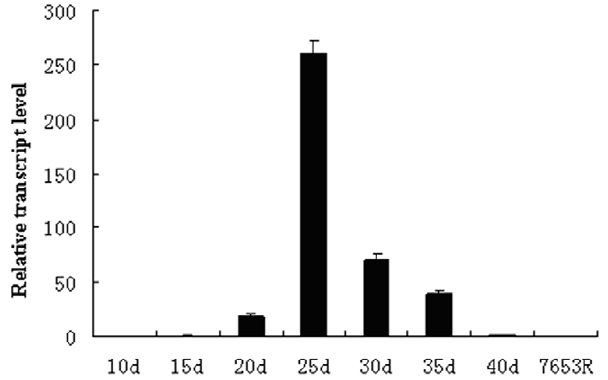
Figure 4. Expression patterns of dmtH gene in free-living cells and symbiotic nodules. Gene expression levels were examined by real-time RT-PCR. Nodules were collected on different days after inoculation with 7653R. Expression levels of dmtH were highest in nodules at 25 dai, and hardly expressed in free-living cells. Histograms represent quantification of the products normalized to the constitutive control rnb . The experiment was repeated three times.